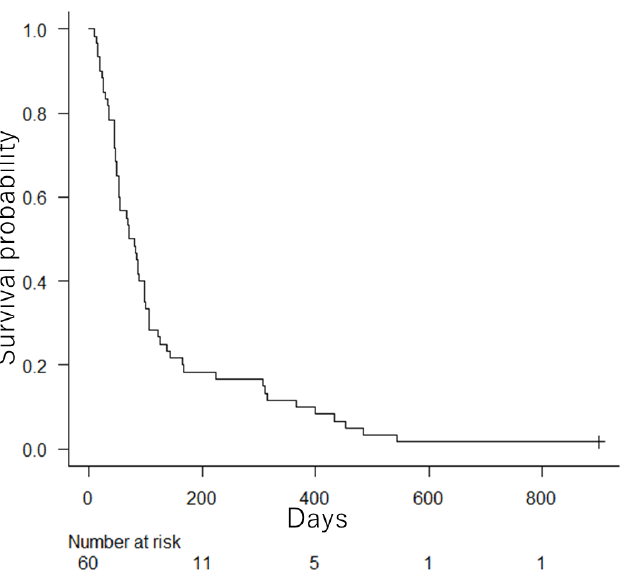
Figure 6. The survival curve after duodenal stenting. The median survival time was 75.5 days (95% confidence interval: 52–97 days).